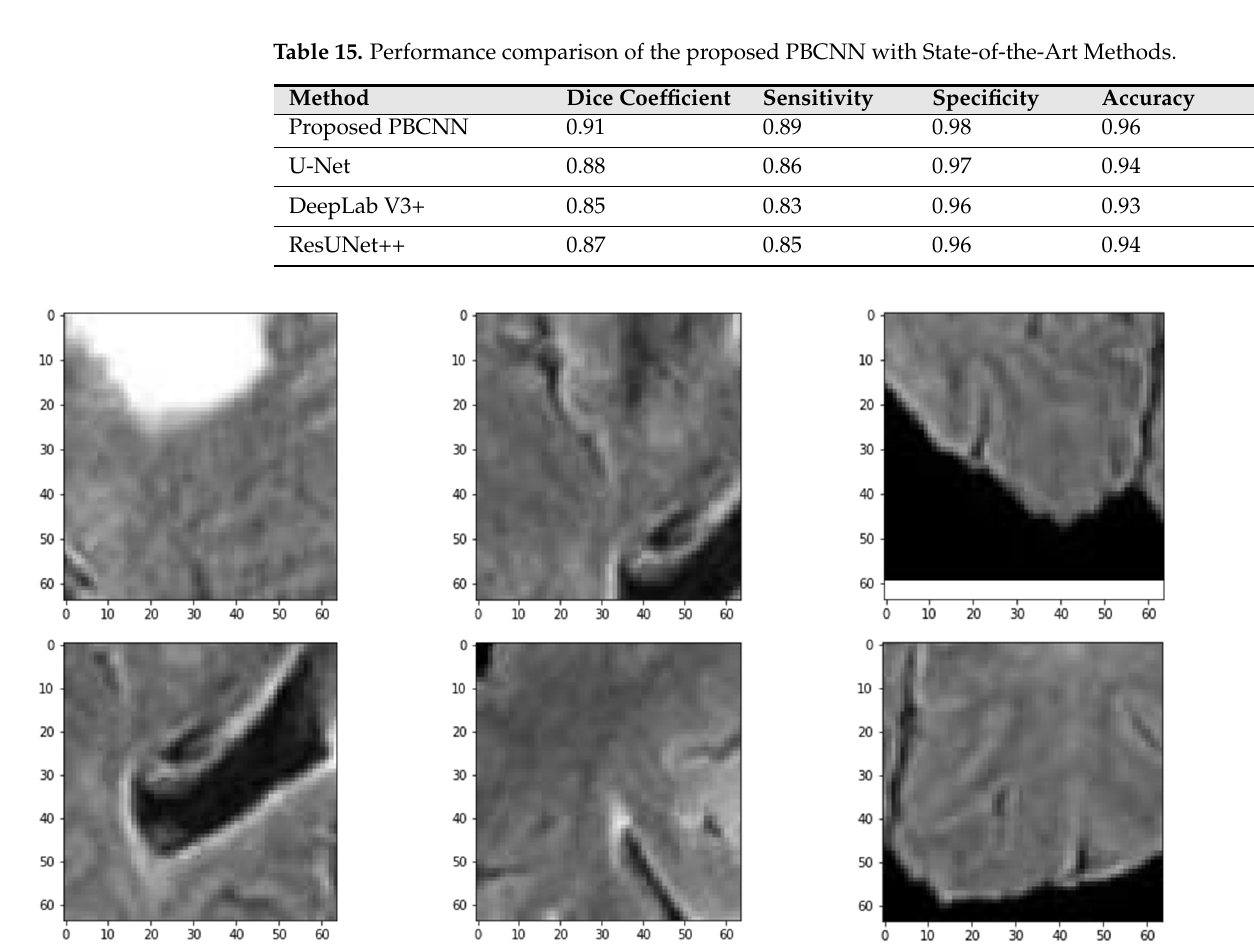
Figure 4. Distribution of MRI Patches with various Configurations. Table 15. Performance comparison of the proposed PBCNN with State-of-the-Art Methods.